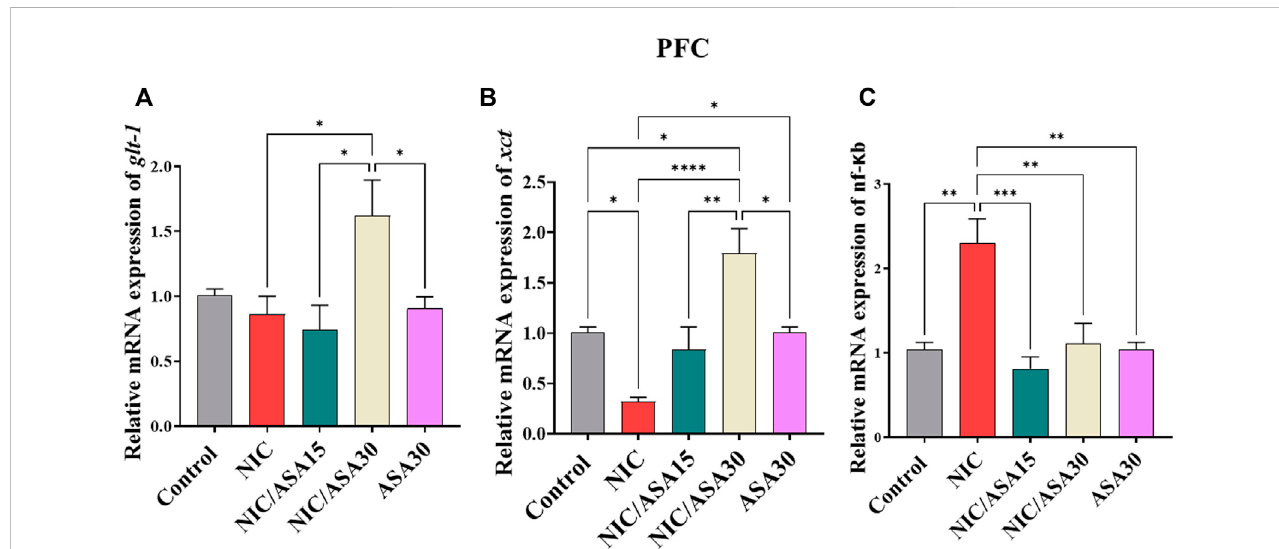
FIGURE 4 Relative glutamate transporters mRNA expression in PFC brain regions after treatments (data expressed as mean ± SEM). (A) glt-1; (B) xct; (C) nf κ B (* p < .05, ** p < .01, *** p < .001; n = 5 for each group).